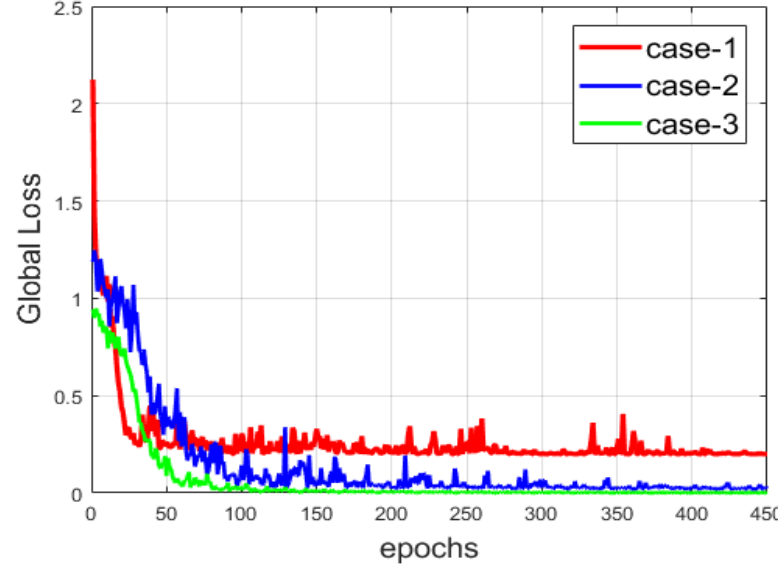
Figure 13. The global loss of the three networks.